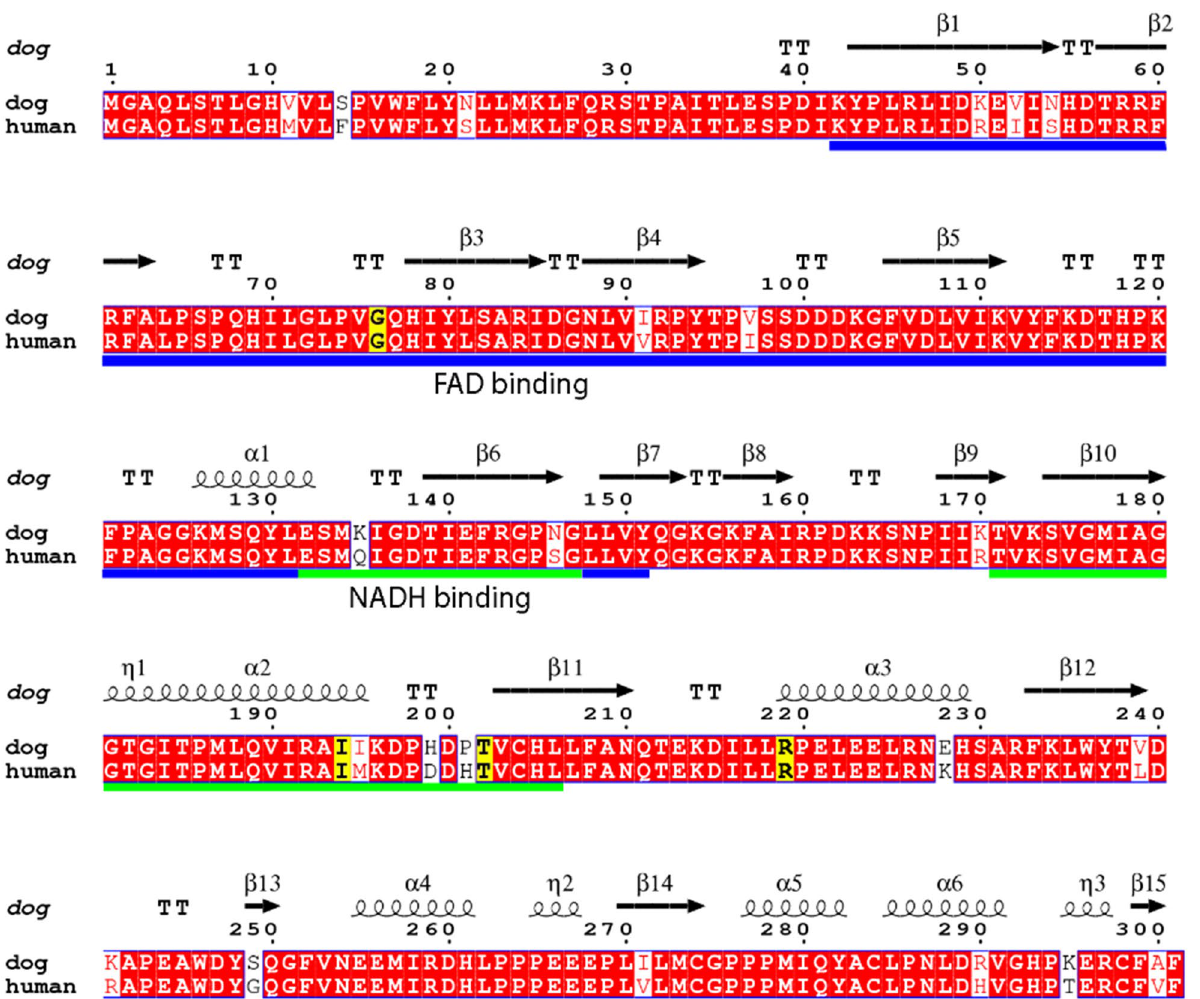
Figure 1. Pair-wise sequence alignment of normal human and canine CYB5R3 gene regions and sites of methemoglobinemia-associated variants in dogs. The CYB5R amino acid sequences were aligned using the EMBOSS/EMBL-EBI server 37 and visualized by ENDSCRIPT program 38 . Residue numbers are labeled according to the canine sequence. The completely conserved CYB5R amino acids between dog and human residues are shaded in red and the variants are shaded in yellow. Secondary elements of CYB5R derived from canine crystal structure are drawn above the alignment. The nicotinamide adenine dinucleotide (NADH) (blue) and flavin adenine dinucleotide (FAD) (green) domains are indicated by solid lines under the alignment. UNIPROT database accession numbers are: P00387 (human) and Q0X0E5